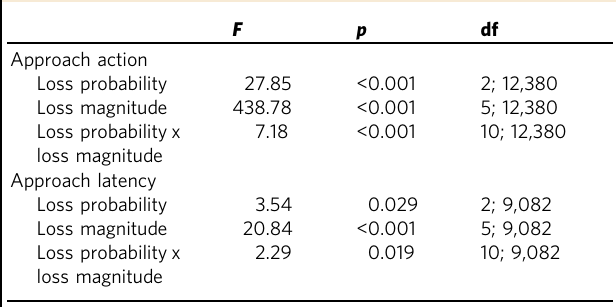
Table 1 Effect of loss manipulations on behaviour (approach action, and approach